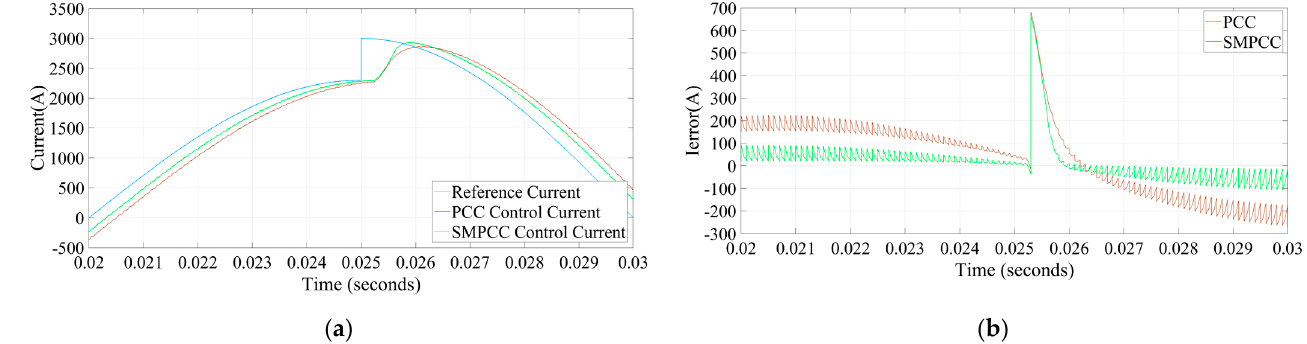
Figure 7. Simulation of a sudden increase in the output reference current amplitude. ( a ) Control current; ( b ) Current error.